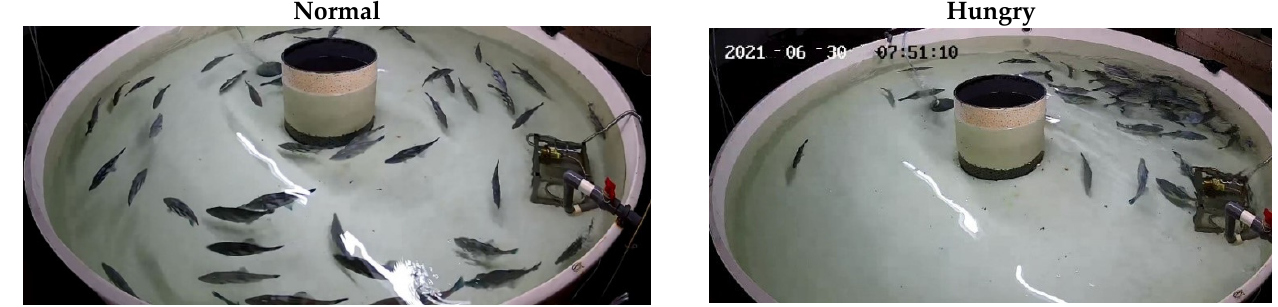
Figure 1. Thamnaconus modestus (black scraper) normal and starvation behavior during the experiment (the date in right image is 30 June 2021).